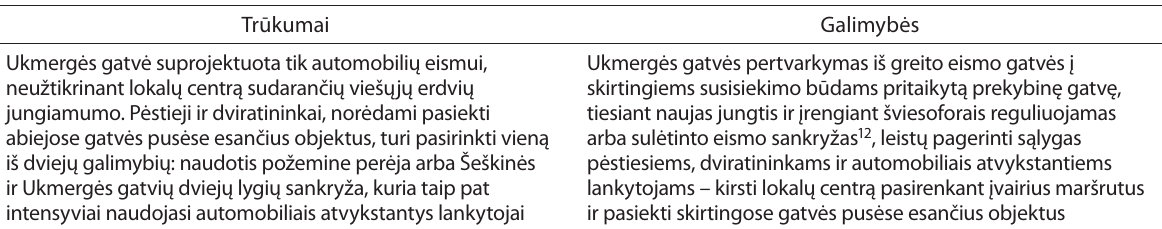
Table 2. Weaknesses and opportunities of the formation of street network in the local centre of Šeškinė Trūkumai Galimybės